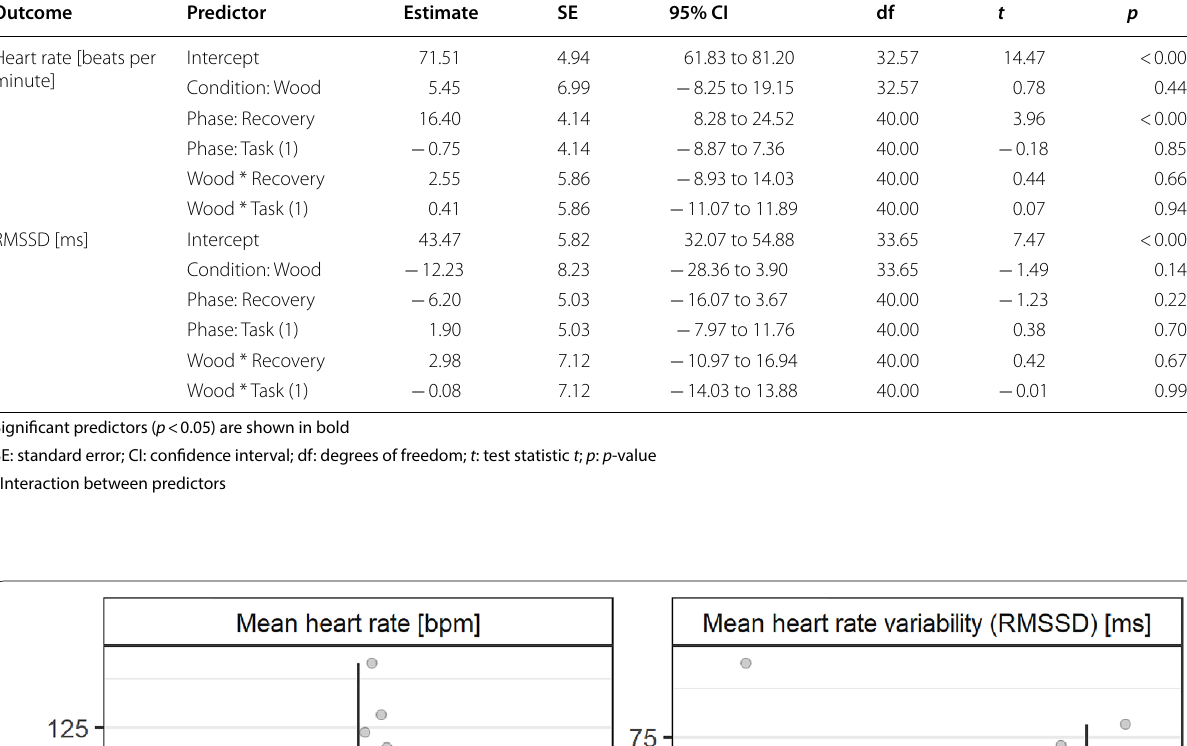
Table 3 Results of the linear mixed models with heart rate and heart rate variability (RMSSD) as dependent variables